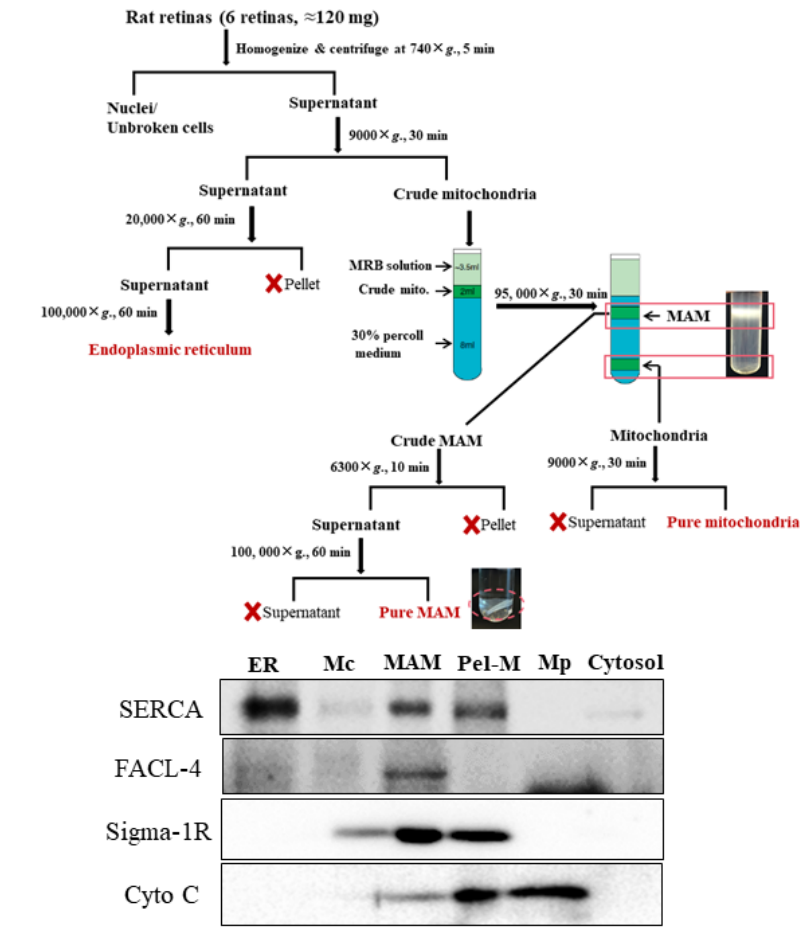
Figure 1. Schematic flowchart of the MAM isolation protocol and Western blot validation of MAM